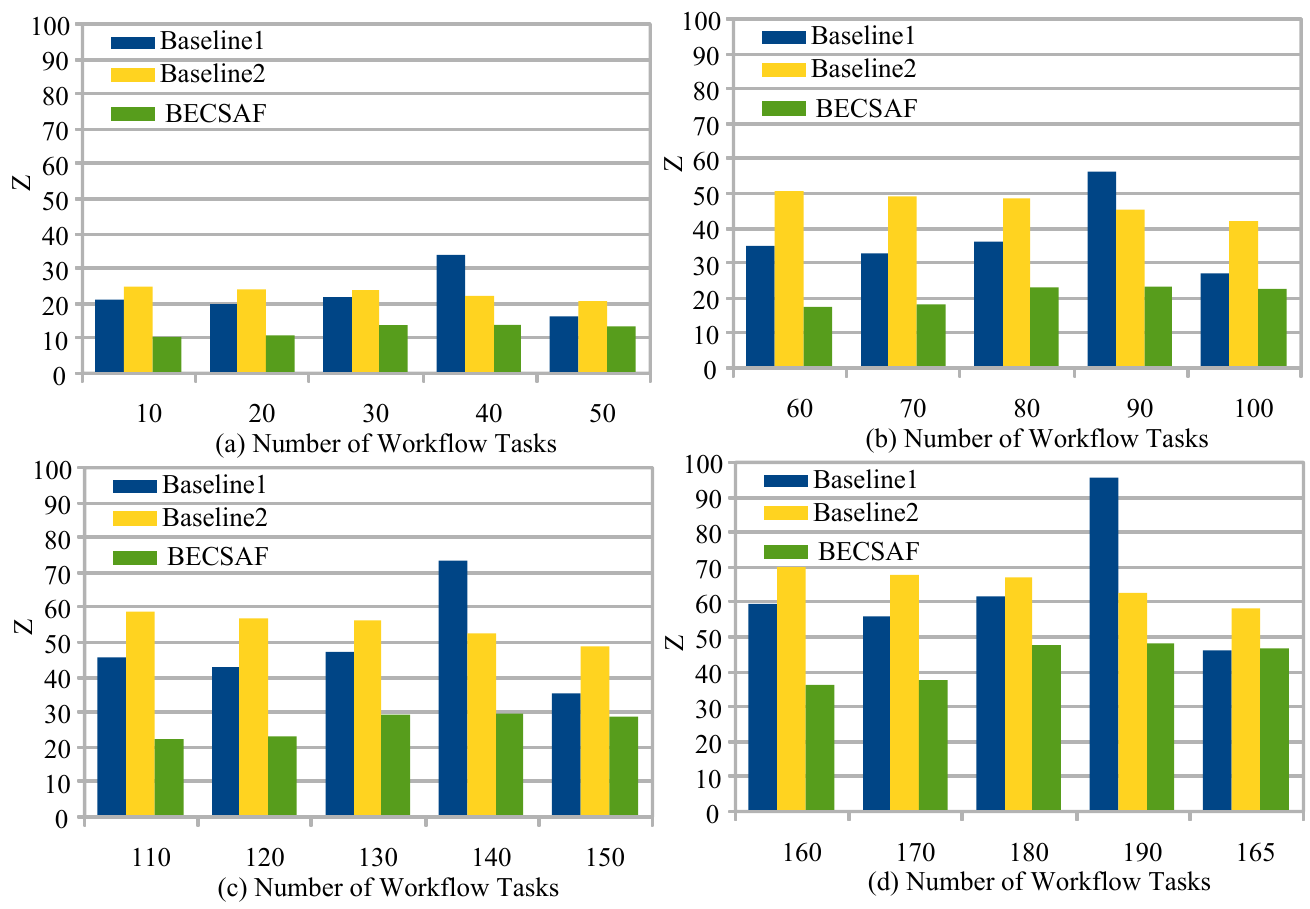
Figure 5. IoMT Workflow Application Execution Cost in Fog-Cloud